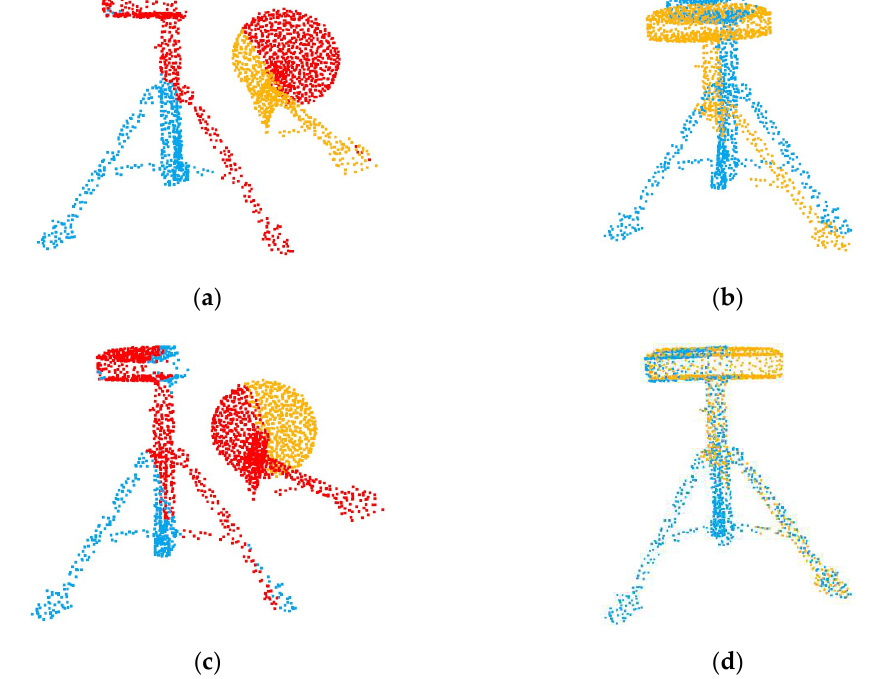
Figure 13. Comparison of registration results with and without Transformer. ( a ) no transformer; ( b ) registration result; ( c ) with transformer; ( d ) registration result.